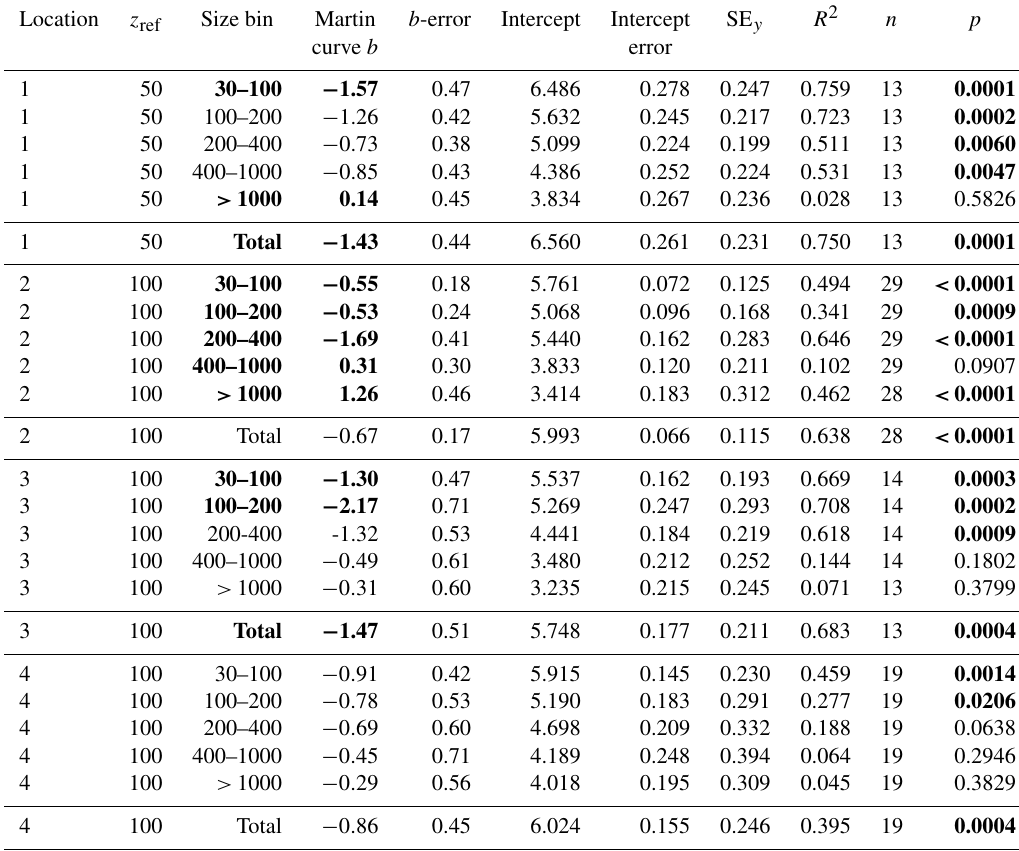
Table 5. Martin curve fits to number flux (all